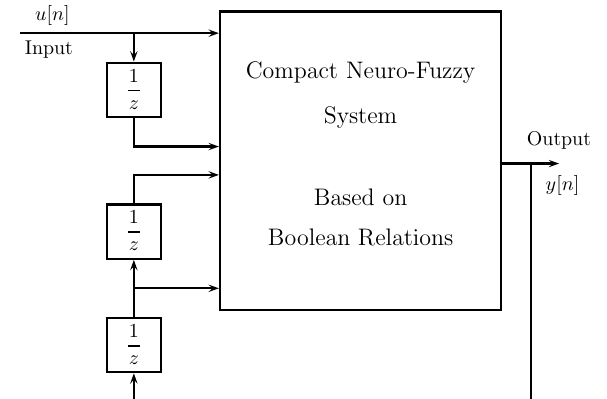
Figure 15. Model employed for the